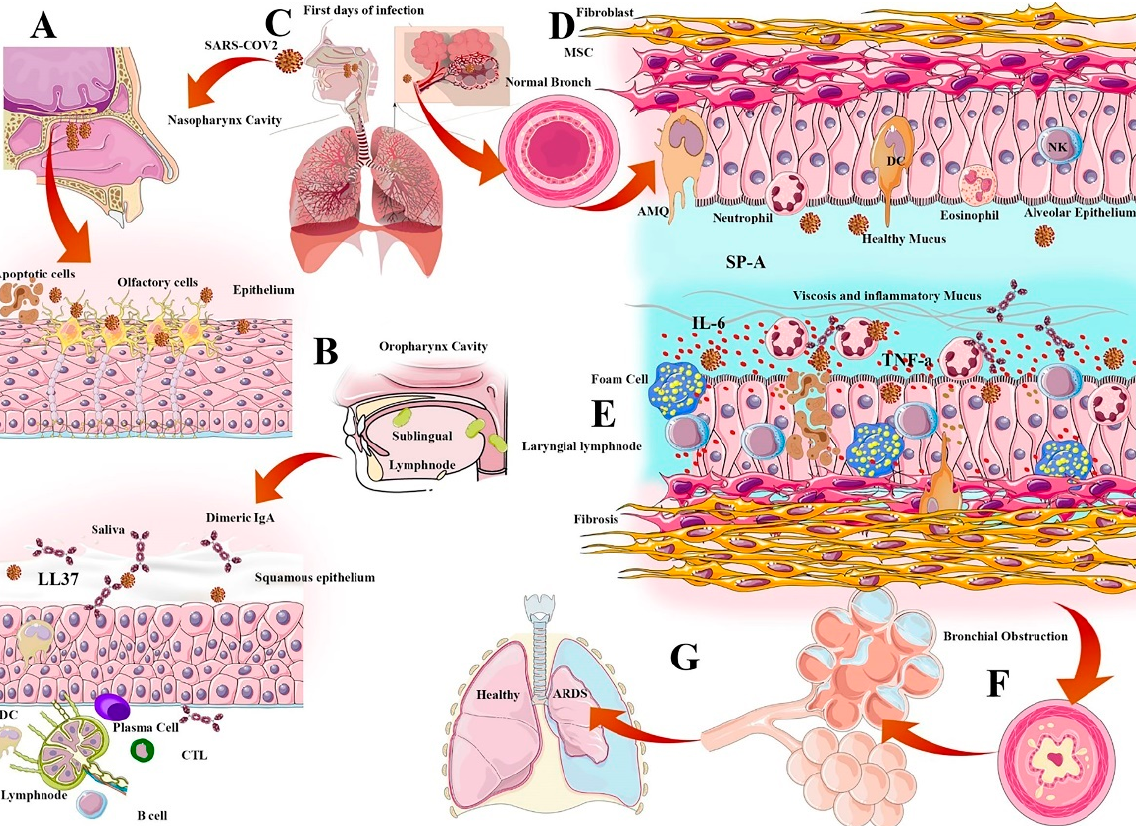
Figure 1. ( A ) Nasal virus entry homing in the nasopharynx cavity and virus attachment on epithelial cells and olfactory neurons. Virus replication in olfactory cells can decrease the ability of smell sensing and cause inflammation in the nasopharynx. ( B ) Oral cavity, salivary component including dimeric IgA, cathepsins, and sublingual and laryngeal lymph nodes are the first line of lymphoid tissue and antibody production. ( C ) Oral-nasal virus entry, oropharynx cavity, and virus attachment on the epithelial cells of throat. ( D ) Normal alveoli in first days of virus entry: thin layer of fibroblasts, low density and distribution of immune cells in a single epithelial layer, eosinophil and neutrophils number in a normal range. ( E ) Severe infection in the alveolar region: macrophages became foam cells. Inflammatory agents induce mucus secretion and increase the viscosity of the mucosal barrier. Alveolar epithelial cells die via apoptosis or viral cytolysis, NK cells increment, and neutrophils induce a cytokine storm. ( F ) Inflammatory conditions induce fibrosis and fibroblast cells proliferation, which can cause thickness of the alveolar cavity, resulting in respiratory distress. ( G ) Lung obstruction results in decreased respiratory